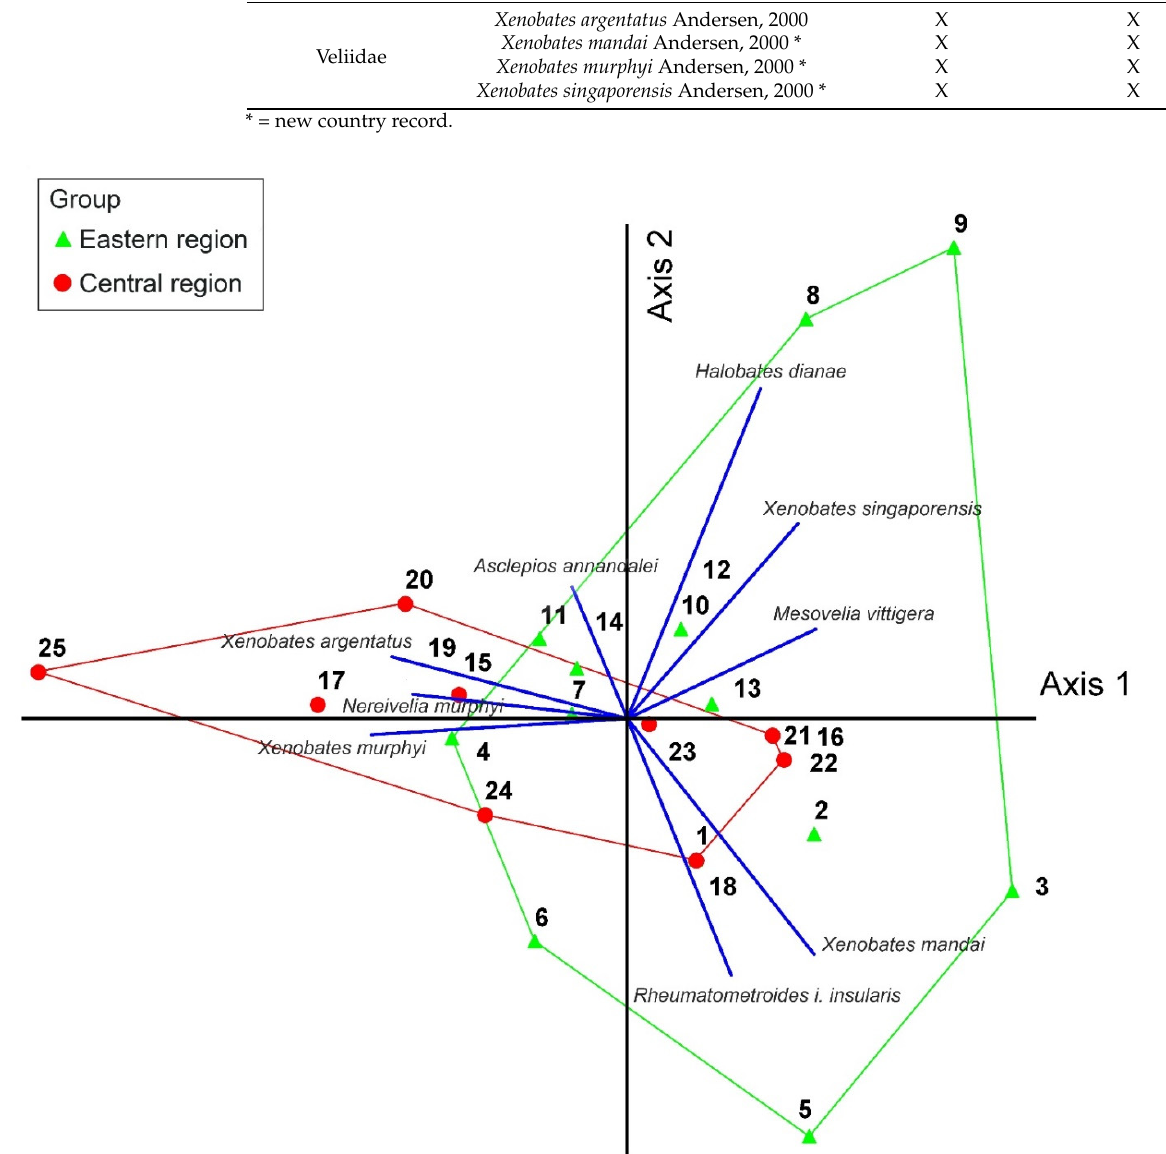
Figure 5. Principle component analysis (PCA) on species richness of Gerromorpha of each collecting site. The first and second PC axes explain 24.370% (eigenvalue: 2.193) and 16.909% (eigenvalue: 1.522) of the variation in the data set, respectively. Numbers refer to collecting sites (see Table 1).